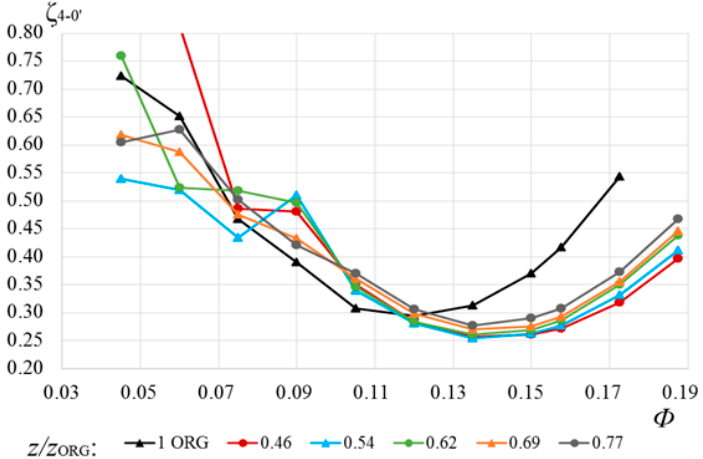
Figure 17. The loss coe ffi cient characteristics of the return channel after preliminary design and of the optimized variants with di ff erent numbers of